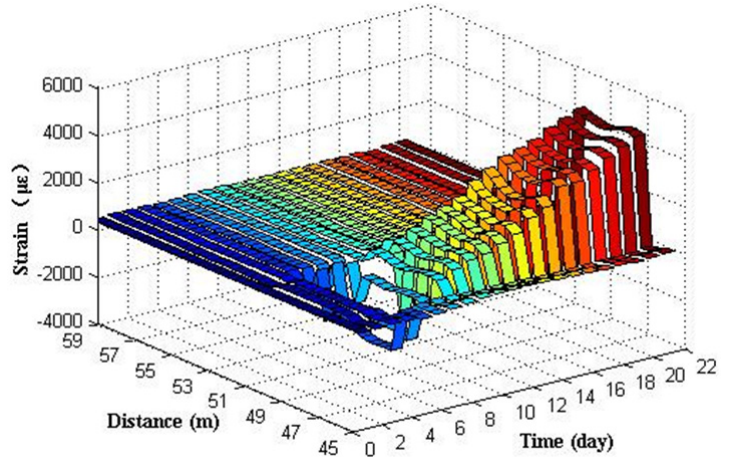
Figure 22. Corrosion strain results of S.4